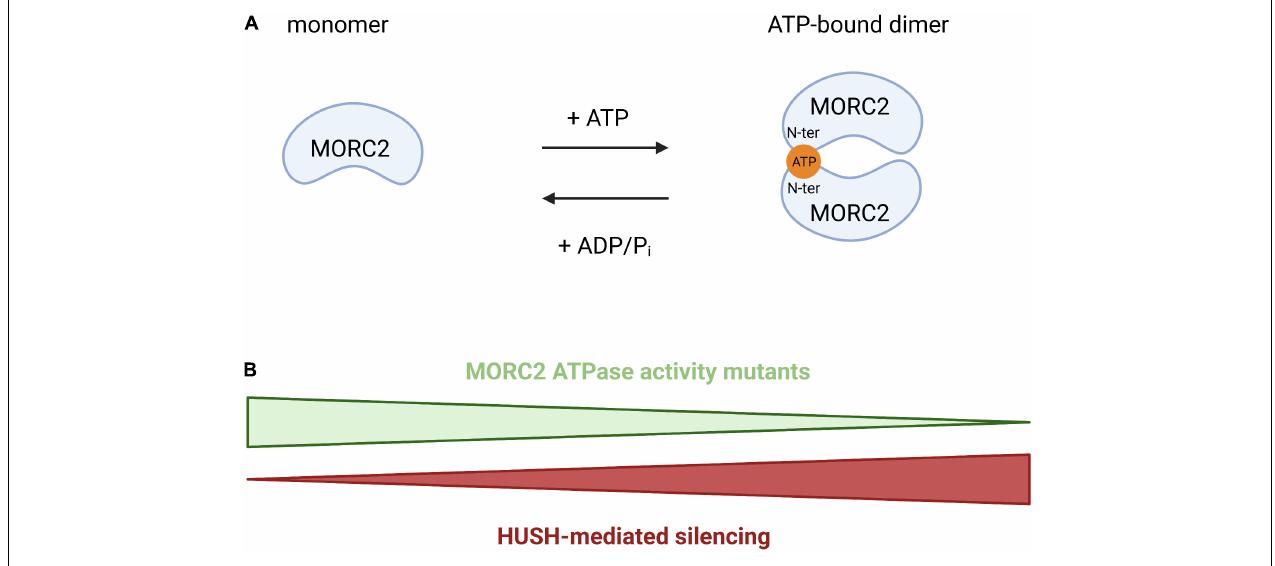
FIGURE 4 | Schematic representation of MORC2 homodimerization through ATP binding. (A) Model proposed by Douse et al. (2018) where the N-terminal part of MORC2 can homodimerize through ATP binding, regulating HUSH-mediated repression. (B) An increase of the ATP hydrolysis will favor the monomeric form of MORC2 leading to a loss of HUSH-mediated silencing and